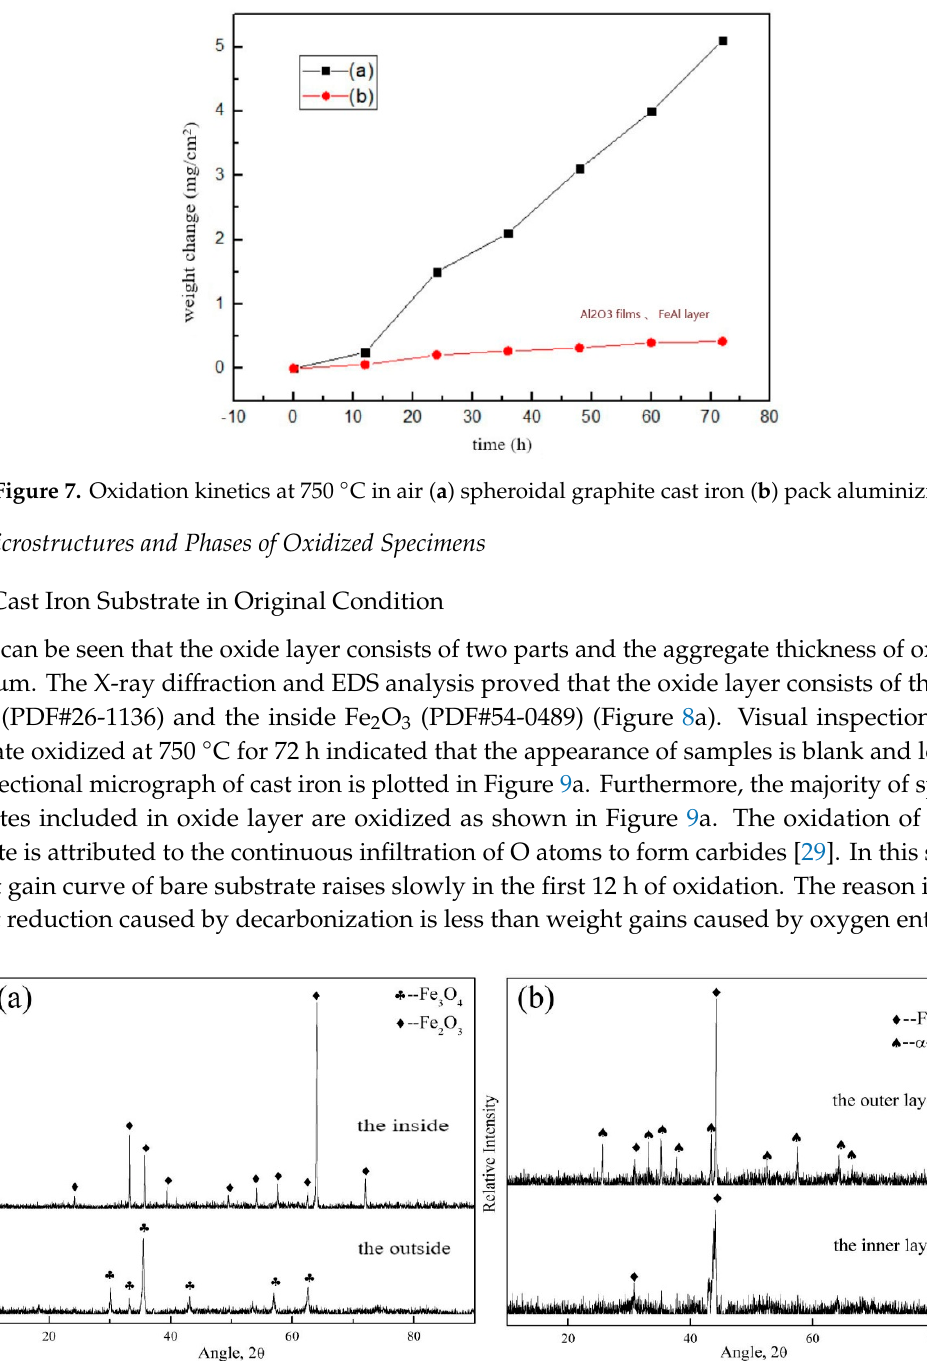
Figure 8. X-ray diffraction patterns of substrate oxidized at 750 °C for 72 h ( a ) spheroidal graphite cast iron ( b ) pack aluminizing.